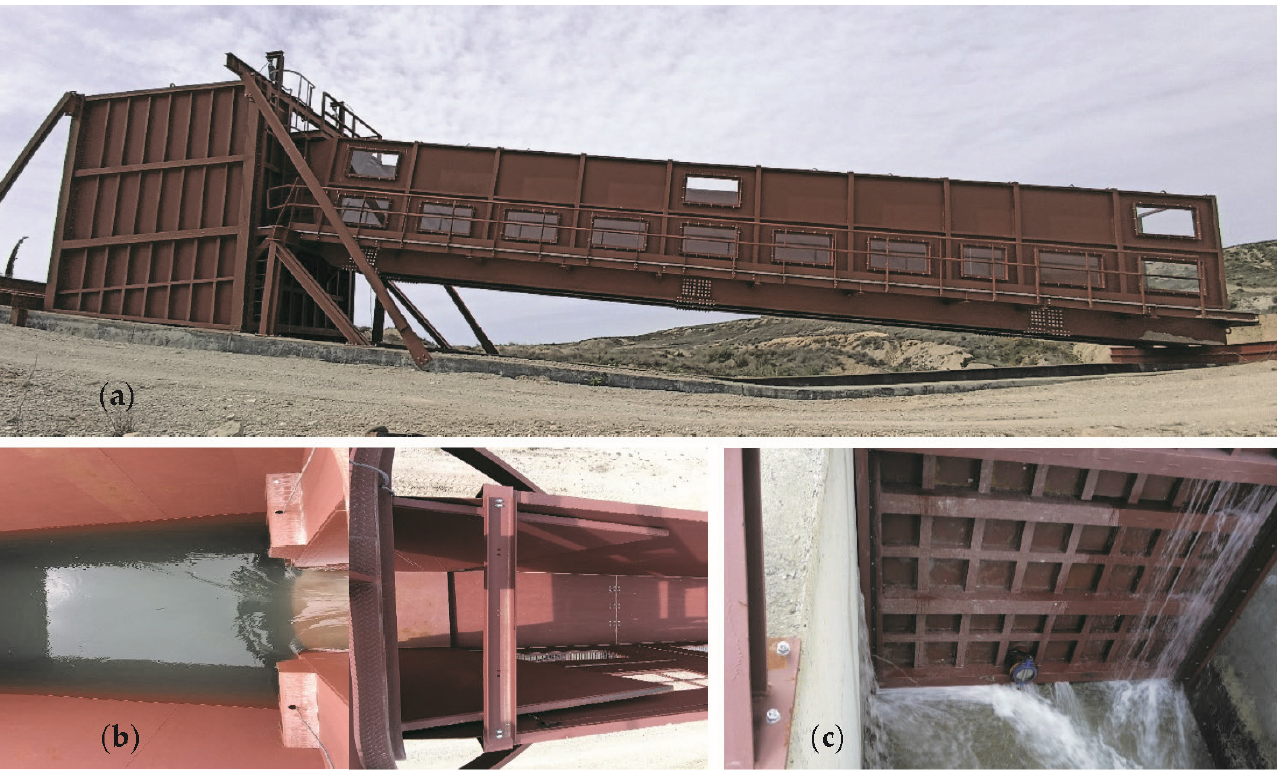
Figure 5. ( a ) General view of the supply tower and the test chute before being lowered to the bottom of the auxiliary channel ( b ) Photographic montage of the water inside the supply tower (left) exiting towards the test chute (right). ( c ) Wall gate of the supply tower and 250 mm diameter butterfly valve to facilitate its operation by emptying the water retained upstream.